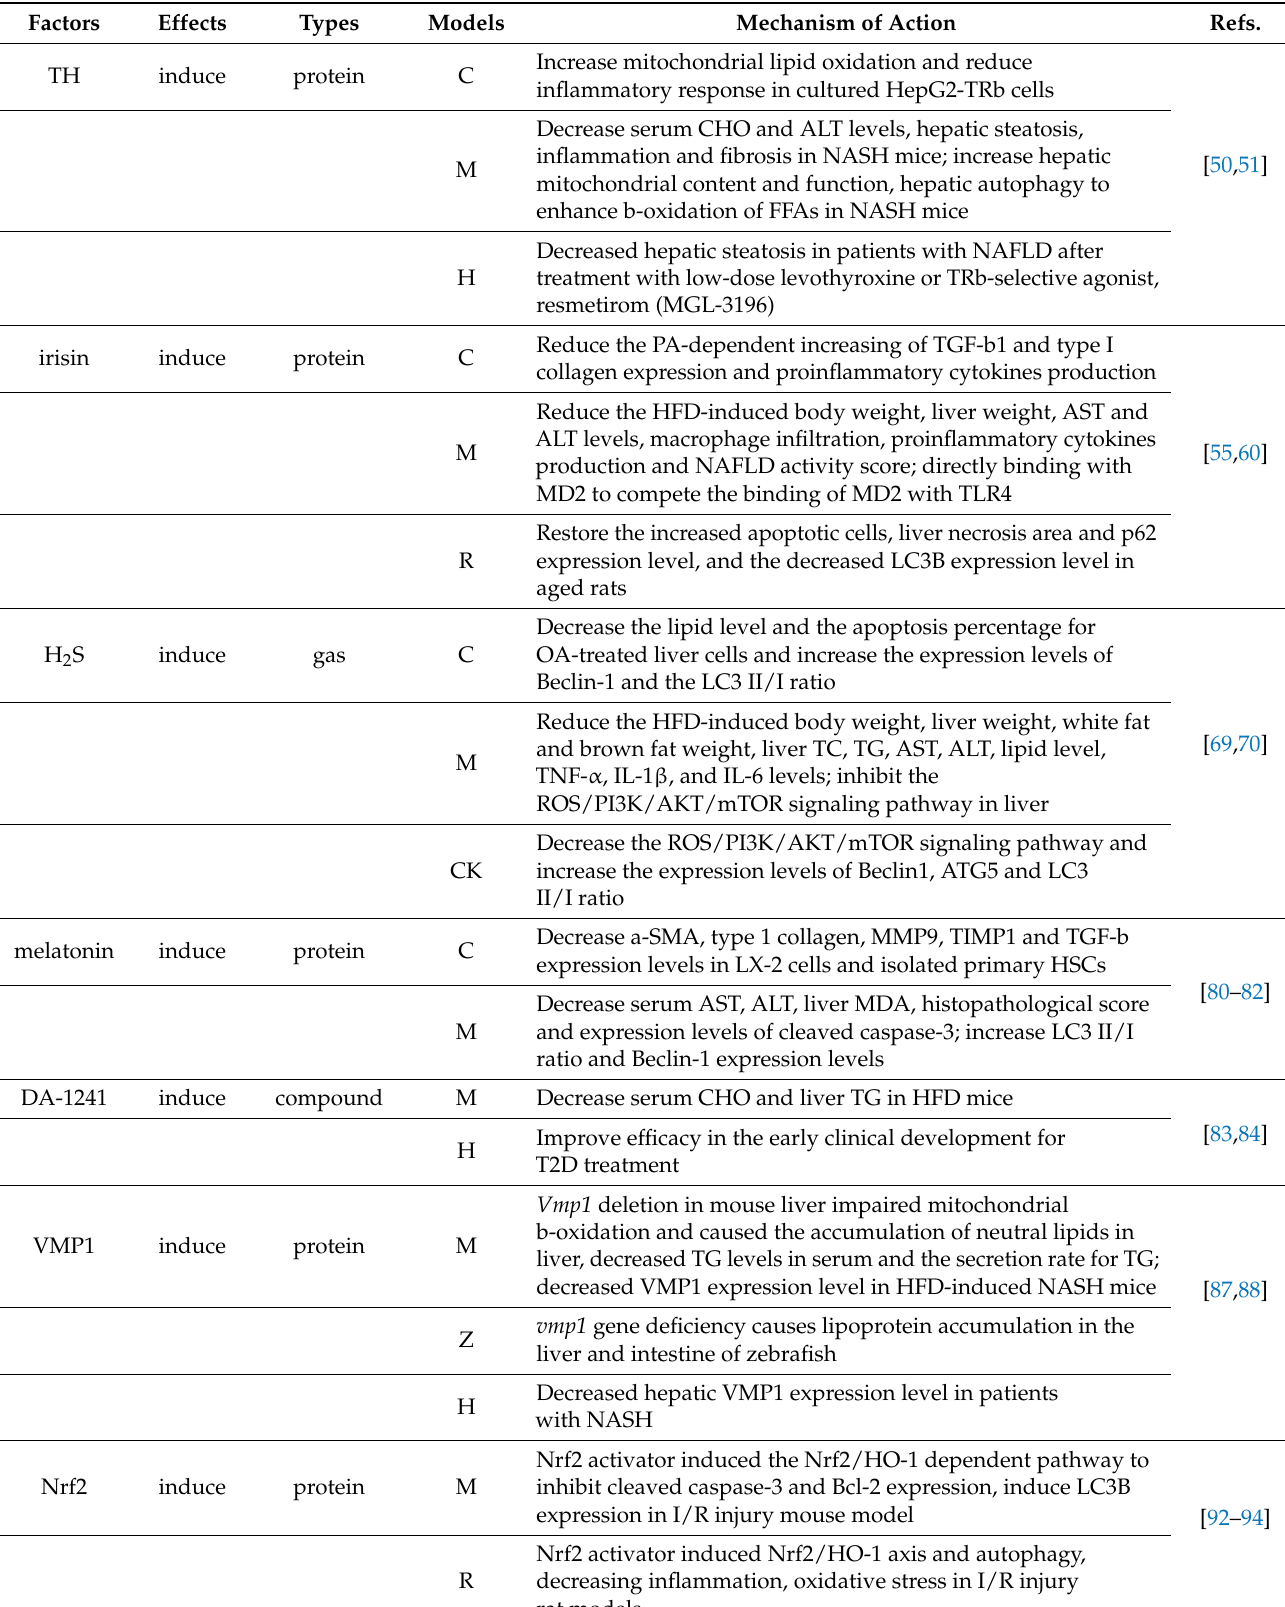
Table 1. Summary of the effects of various autophagy